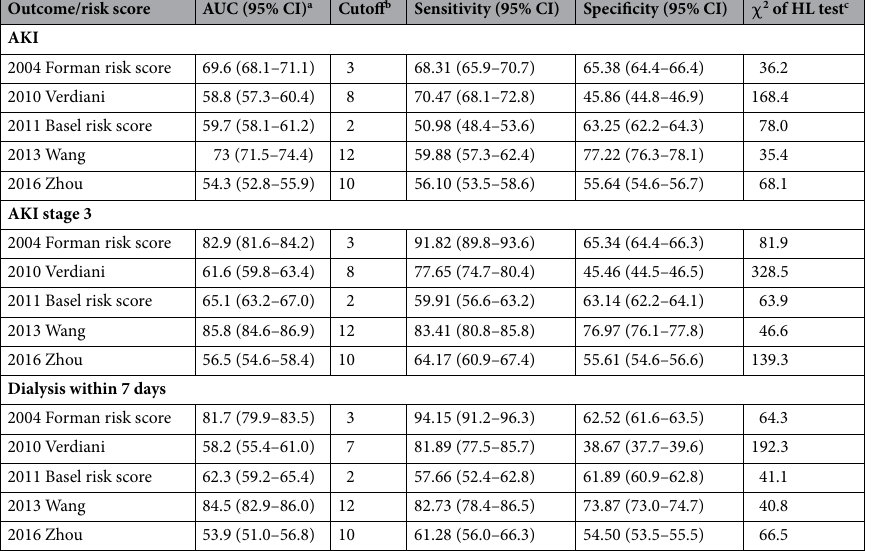
Table 3. Prediction model performance in discrimination and calibration outcomes of interest. AKI , acute kidney injury; AUC , area under the receiver operating characteristic curve; CI , confidence interval; HL , Hosmer–Lemeshow. a: Larger numbers indicate better performance; b: Determined using the Youdex index; c: Lower numbers indicate better